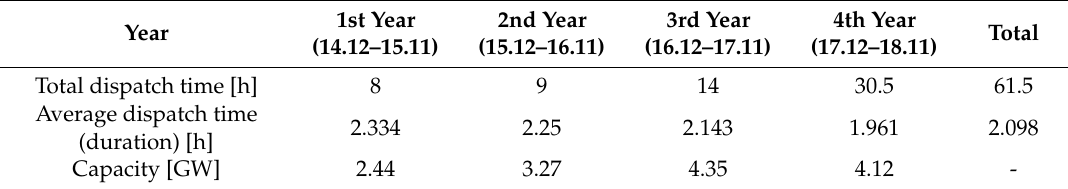
Table 1. Reliability DR operation results in Korea, in 12-month increments.